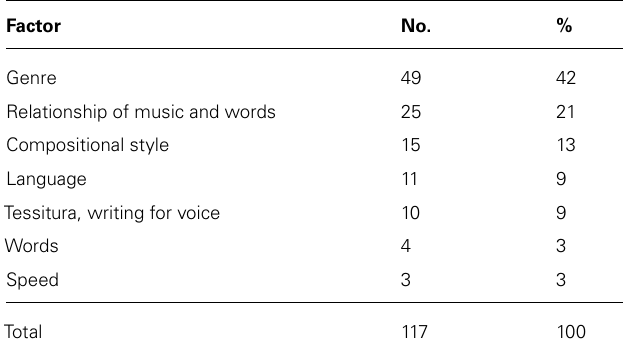
Table 3 |The number of statements (No.) and percentage (%) of environment-related factors affecting sung text intelligibility.